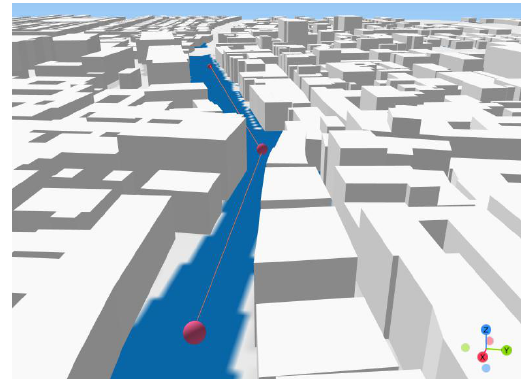
Figure 7 . The Viewshed of Hongfu Bridge (pink ball in the middle), looking from East to West